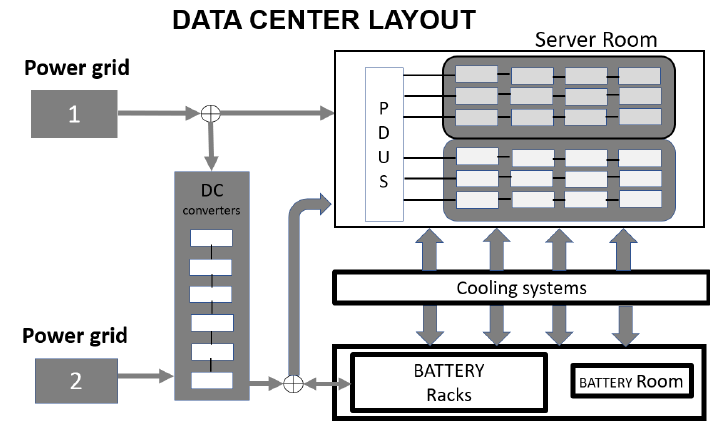
Figure 1. Data center layout. PDUS = Power Distribution